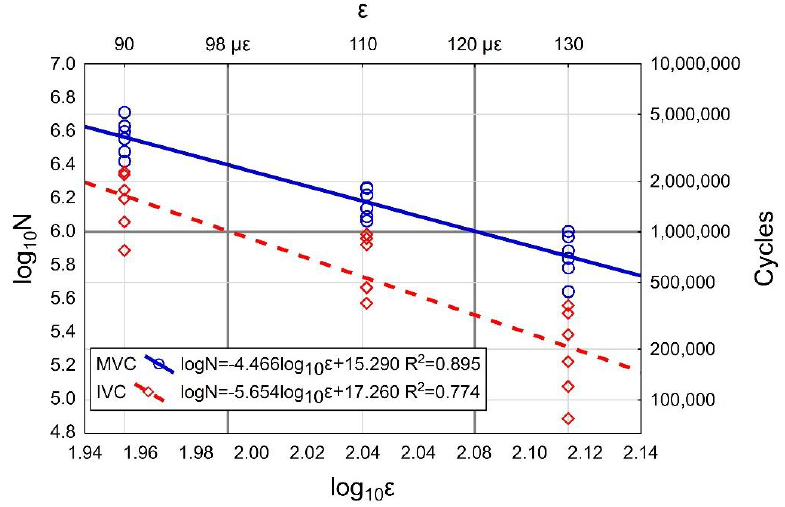
Figure 13. Visual representation of the fatigue behavior of the AC 16 W 35/50 mixtures determined